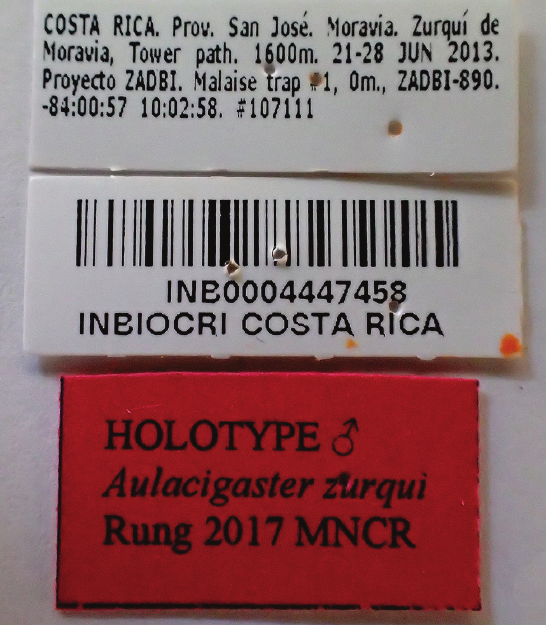
Figure 10. Aulacigaster zurqui sp. nov.: digital photographs of the labels pinned with the male